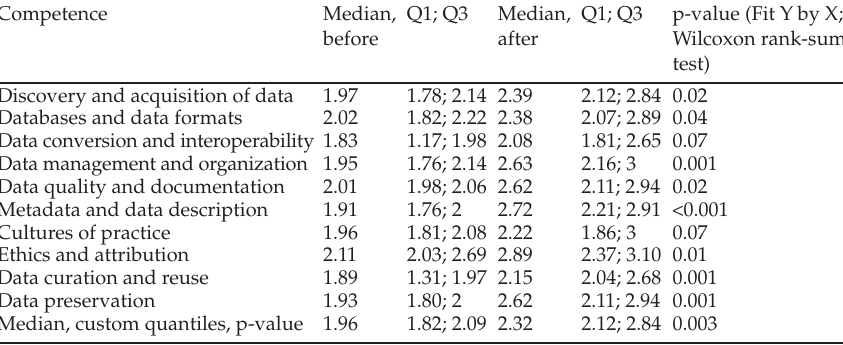
Table 6: Competencies before and after BRDM 2019 (medians, custom quantiles, and p-values).